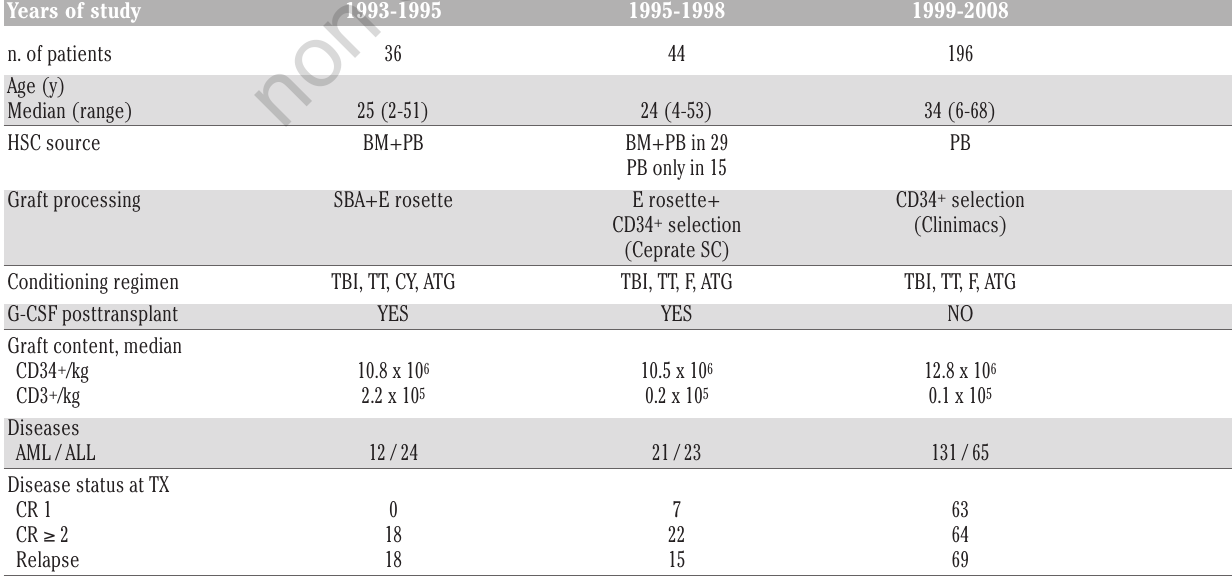
Table 1. Modifications in the Perugia Haplotransplant